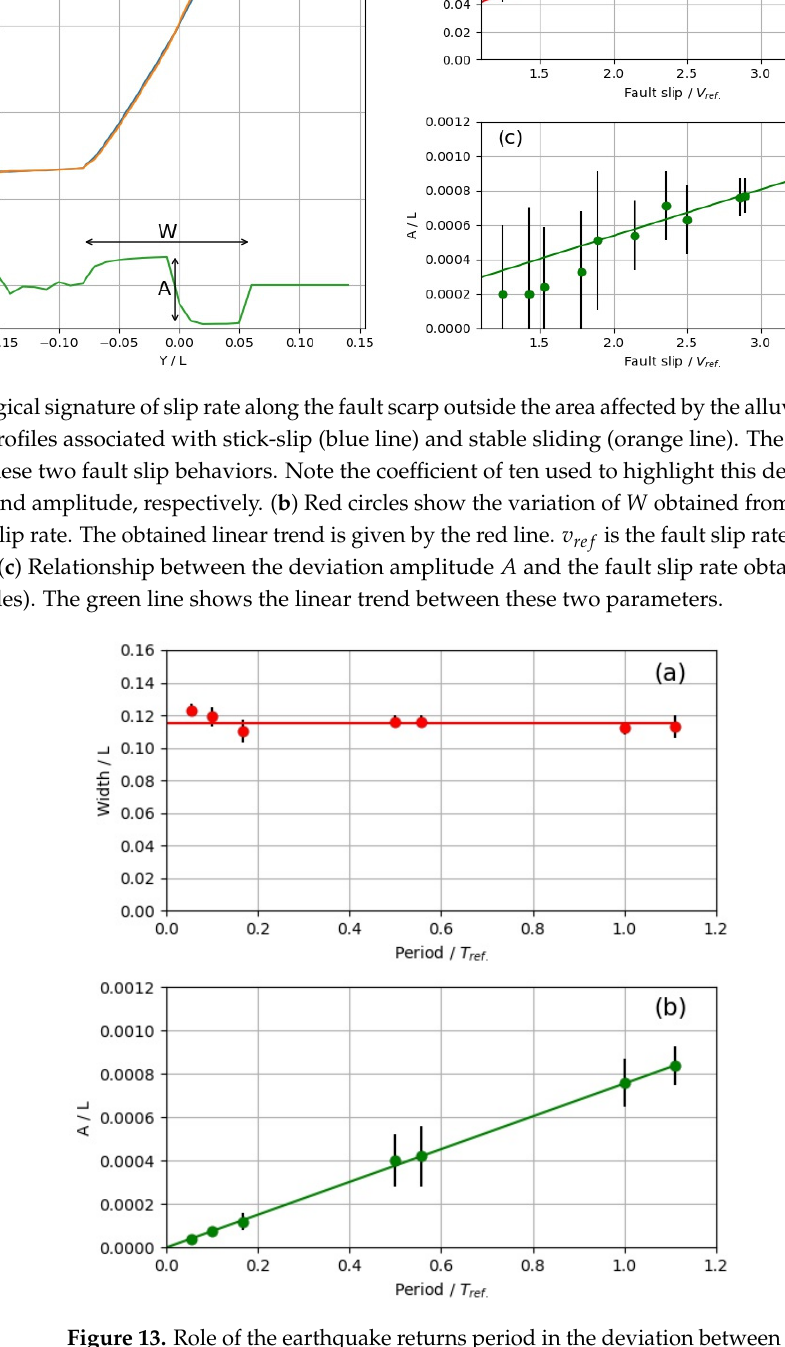
Figure 13. Role of the earthquake returns period in the deviation between slick slip and stable slid- morphology. A slip rate of 3 × v ref and modeling duration time of t end including a fan building period and tectonic forcing were assumed (see Table 1). ( a ) Red circles show the variation of W obtained from numerical modeling with respect to the earthquake return period. The obtained linear trend is given by the red line. T ref is the return period used in the reference model (see Table 1). ( b ) Relationship between the deviation amplitude A and the fault slip rate obtained from numerical modeling (green circles). The green line shows the linear trend between these two parameters.